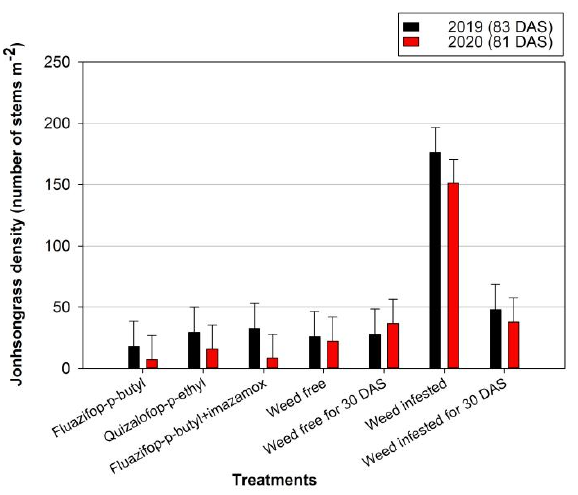
Figure 1. Effects of various control treatments on Johnsongrass dry biomass (kg ha − 1 ) at different days after sowing (DAS), in 2019 and 2020. For each sampling date, error bars indicate the LSD 5% value.